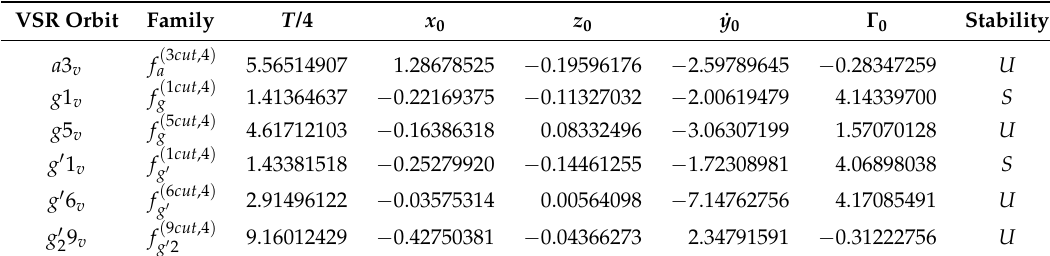
Table 5. Sample members of families of 3D periodic orbits having the O xz − O x double symmetry. These families bifurcate from the second vertical intersection with the O x -axis of the corresponding VSR orbits, presented in the first column. The last column indicates whether each family contains stable parts ( S ) or not ( U )